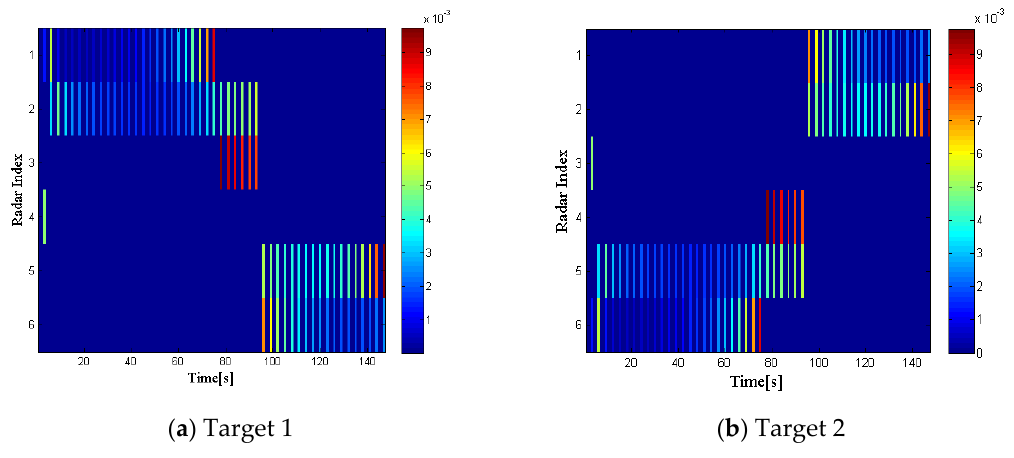
Figure 4. Radar selection and dwell time allocation in RCS case 1.